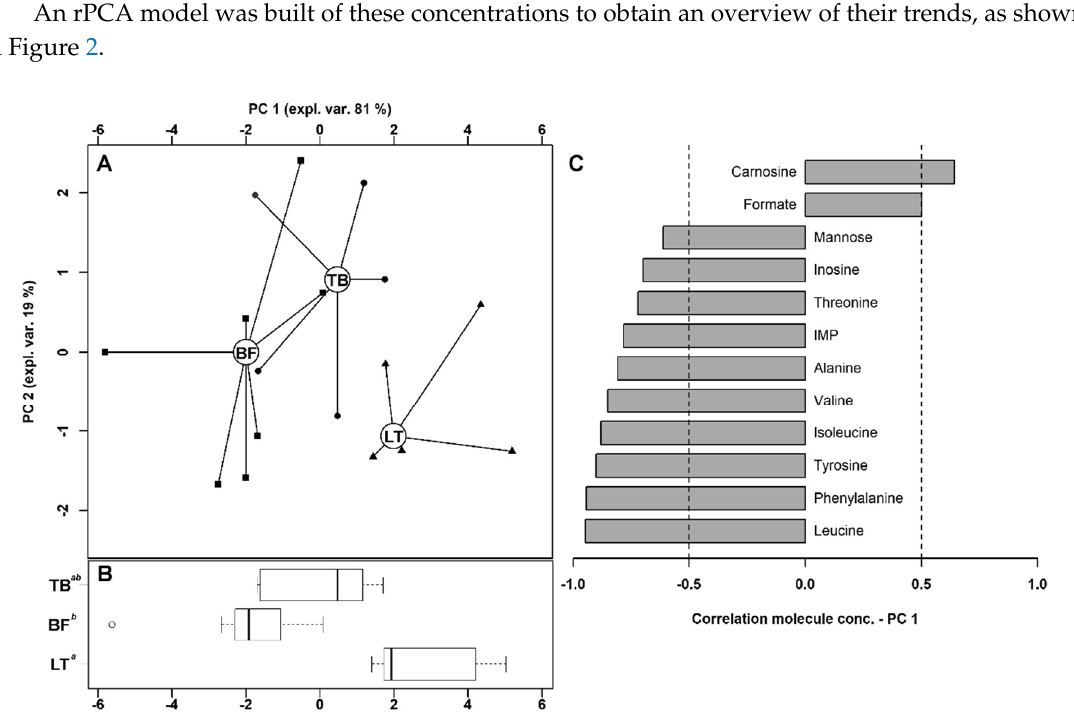
Figure 2. rPCA model built of these concentration of the molecules showing statistically significant differences among different groups. In the scoreplot ( A ), samples from the three groups are represented with triangles (LT), circles (TB) and squares (BF). The wide, empty circles represent the median of each samples’ group. In the boxplot ( B ), the position of the samples along PC 1 is summarized. Different superscript letters identify significantly different groups ( p < 0.05). The loading plot ( C ) reports the correlation between the concentration of each substance and its importance over PC 1.